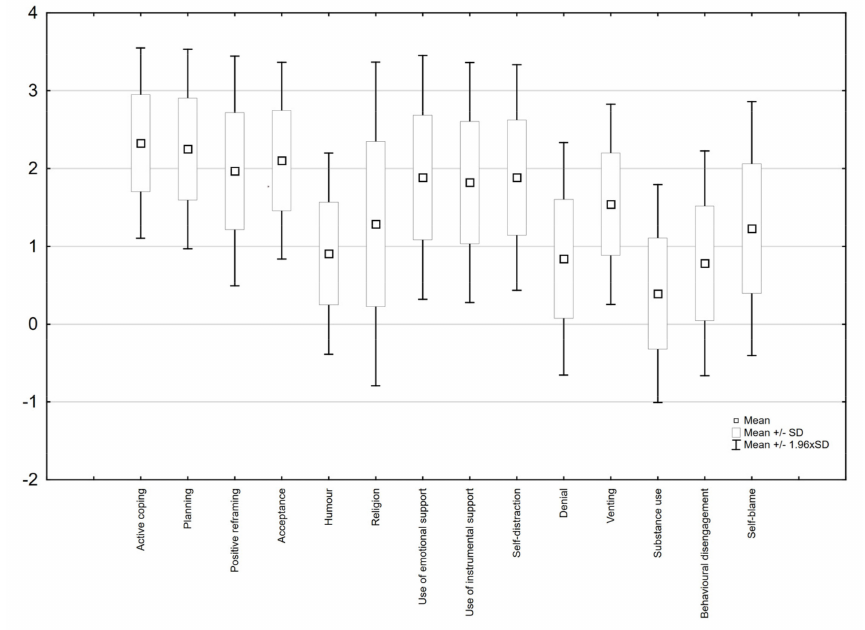
Figure 1. Strategies for coping with stress.